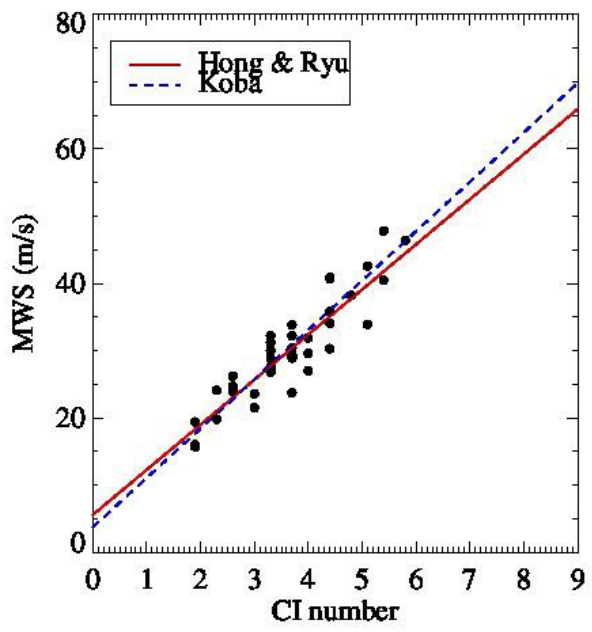
Figure 6. ( a ) MWS (best track) vs. MWS (SMAP) and ( b ) MWS (best track) vs. MWS (Koba scale).